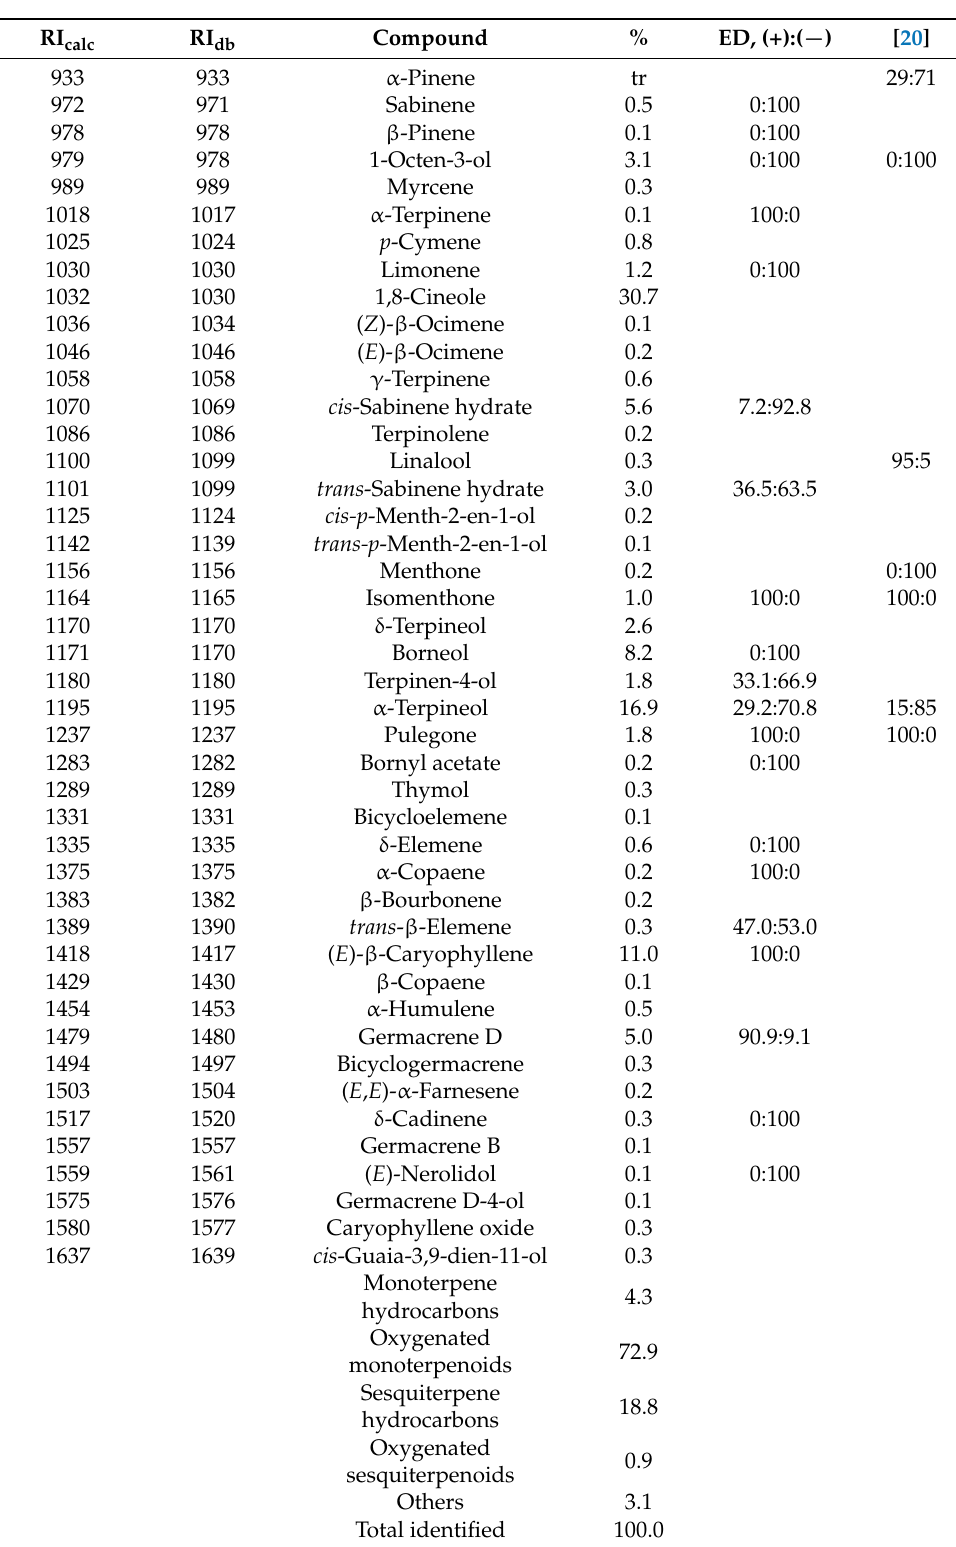
Table 6. Chemical composition of Pycnanthemum incanum aerial parts essential